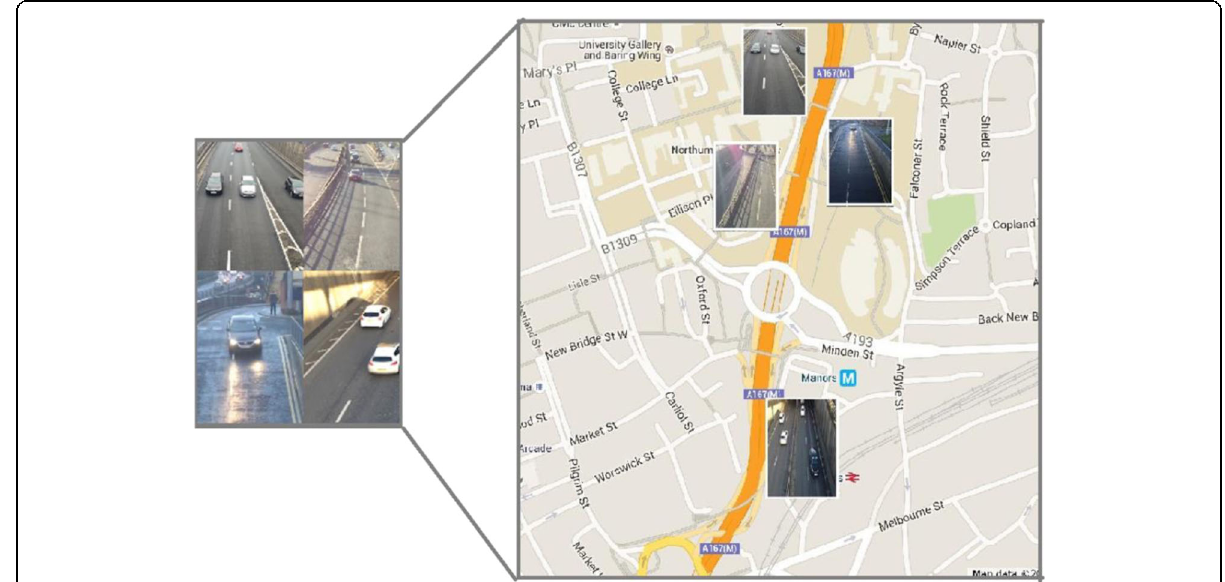
Fig. 21 Holistic visualization of videos on Google Map